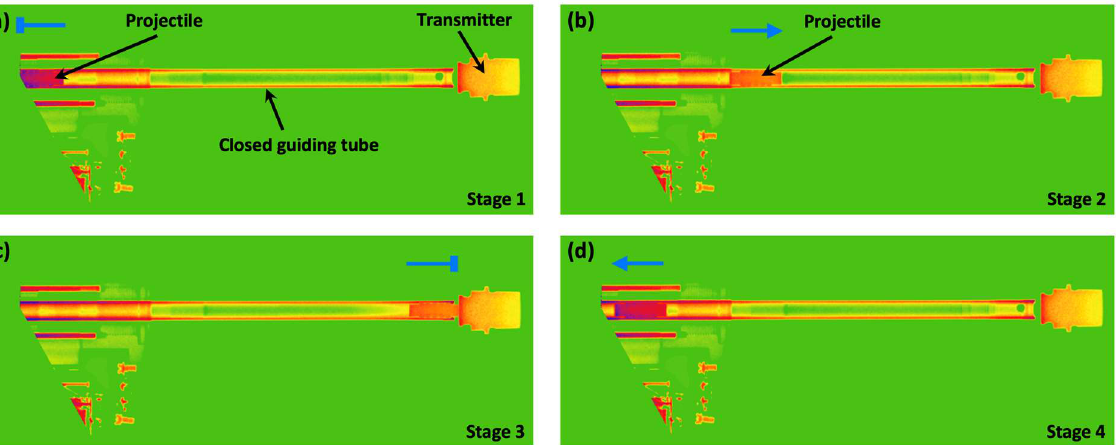
Figure 3. Operation cycle of a typical pneumatic applicator: ( a ) projectile in start position, ( b ) projectile in move, ( c ) projectile hits the transmitter, ( d ) projectile in return position—end of cycle.